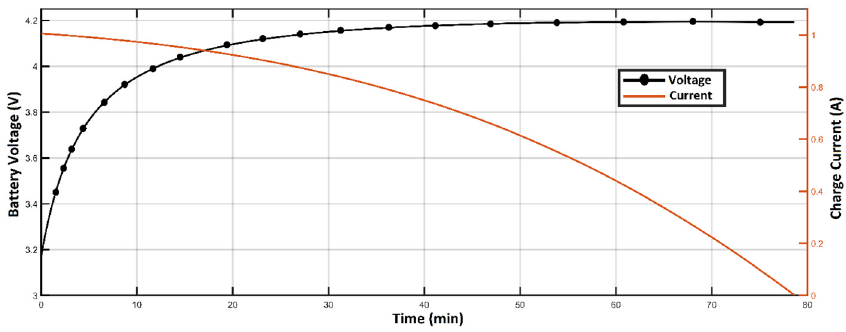
Figure 11. Battery voltage and charge current.